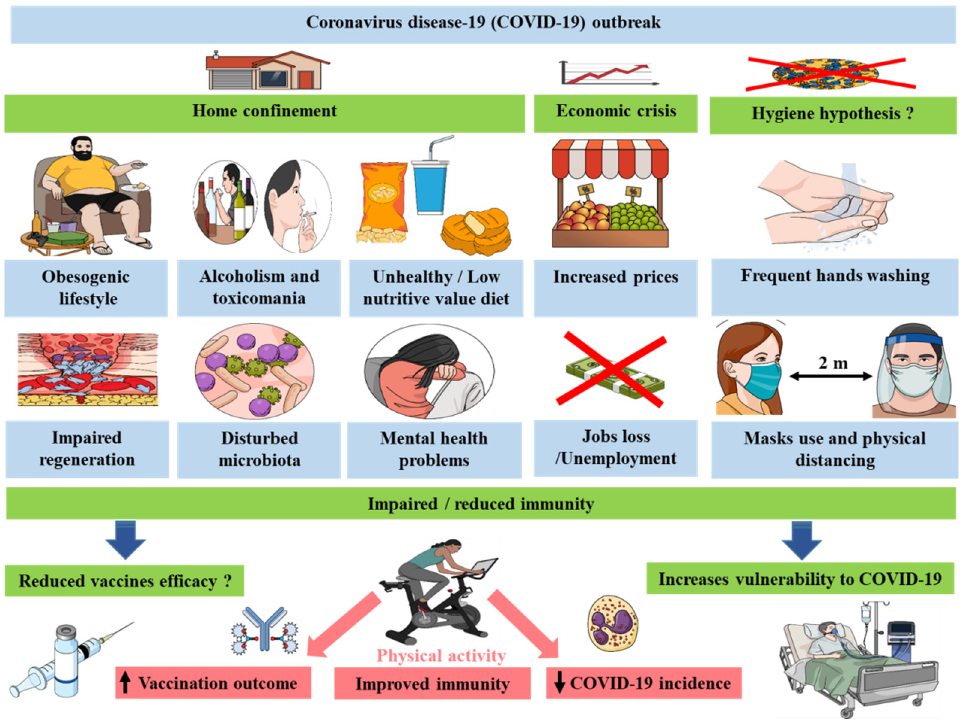
Figure 1. COVID-19 crisis measures lead to reduced immunity via diverse factors that could impact both COVID-19 morbidities and vaccines efficacy.